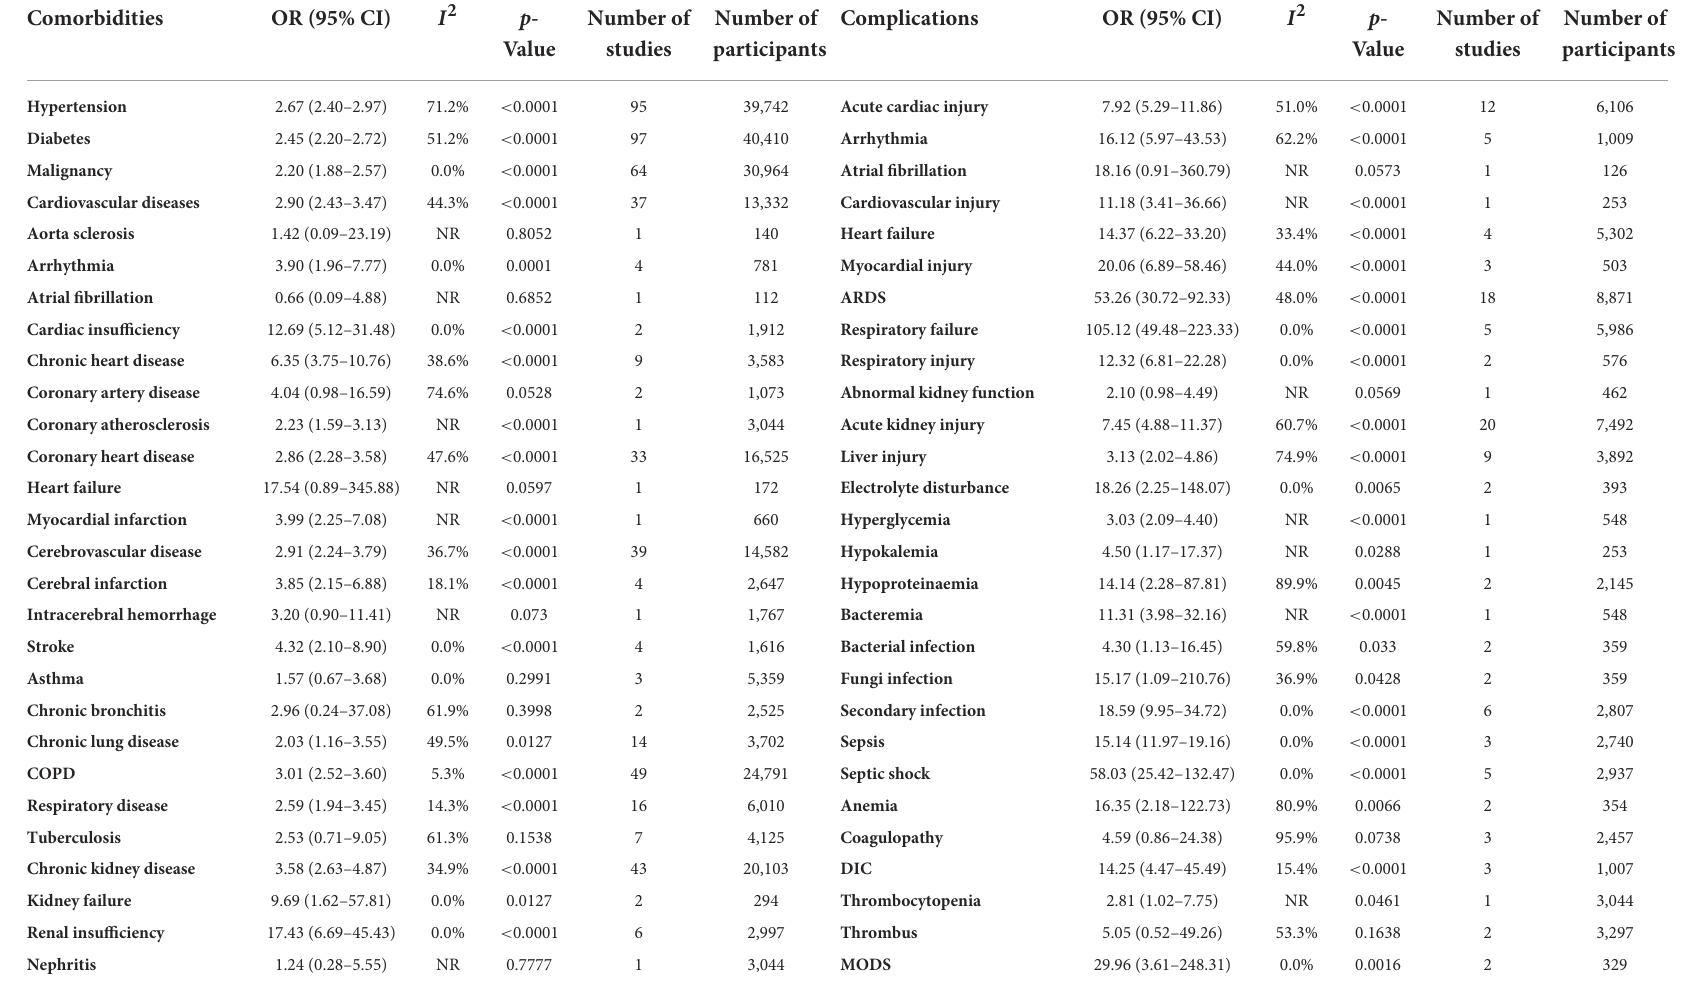
TABLE 1 Meta-analysis summary of comorbidities and complications for COVID-19 by mild/moderate vs. severe/critical.